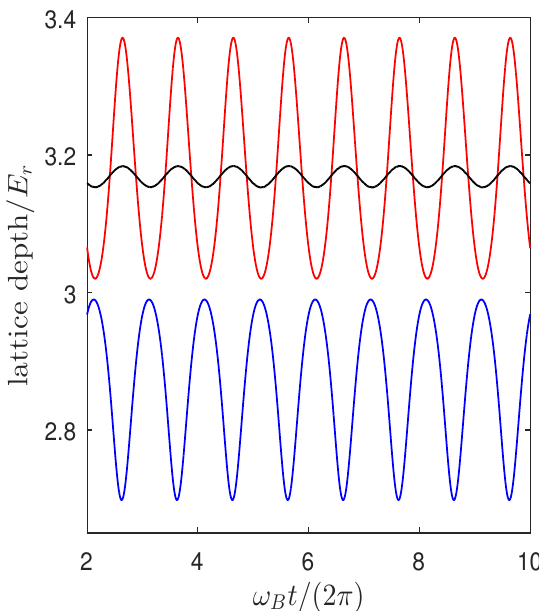
Figure 3. Backaction-induced modulation of the lattice depth (in units of the recoil energy E r = ¯ h ω r ) as a function of time during intracavity Bloch oscillations. The blue (red) curve corresponds to parameters giving uphill (downhill) transport in Figure 2a. The black curve corresponds to the breathing dynamics plotted in Figure